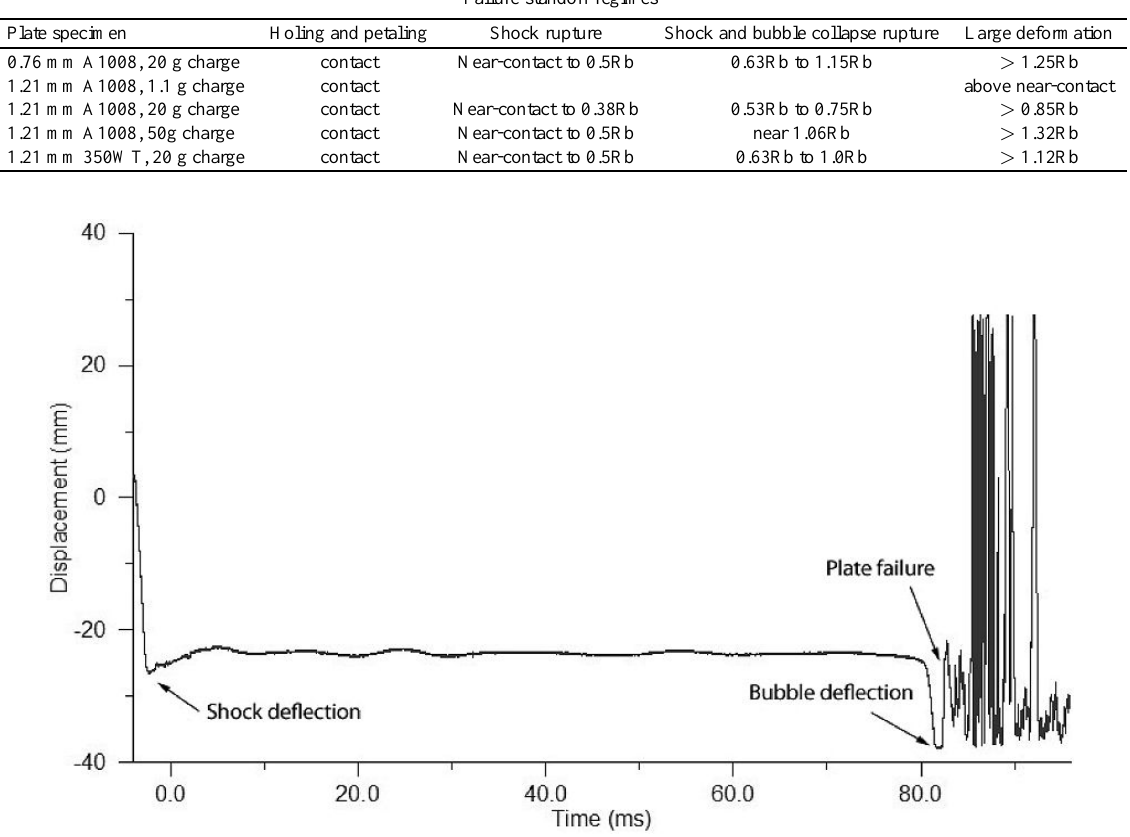
Fig. 9. Dynamic mid-point deflection histories showing plate failure after shock and bubble collapse deflection. The test conditions are a 50 g charge at a standoff distance of 569 mm from a 1.21 mm A1008 steel